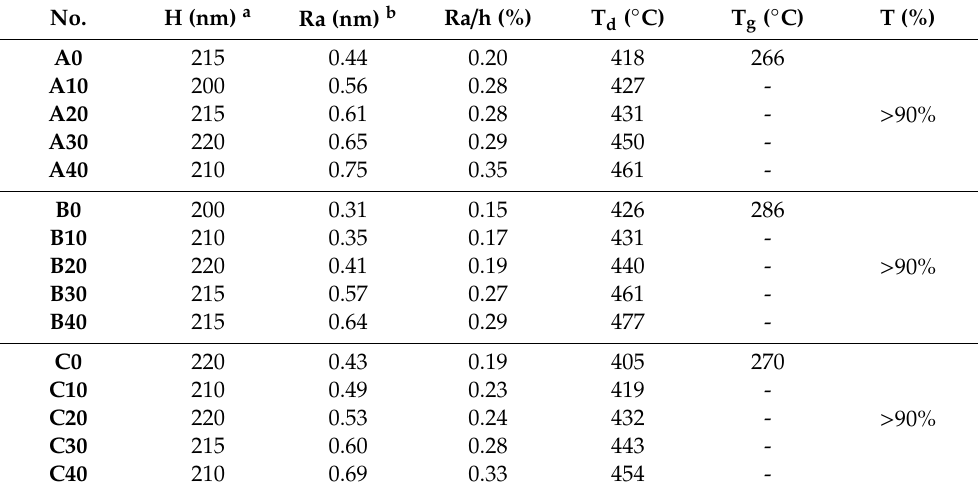
Table 1. Summary of properties of the prepared dielectric hybrid